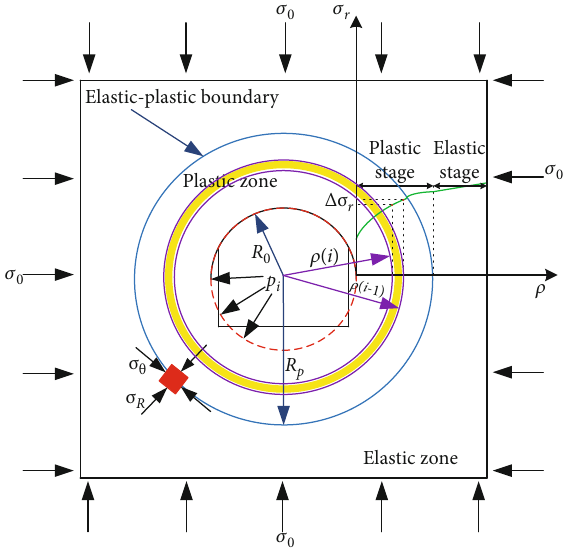
Figure 7: Radial stress distribution and plastic zone of equivalent circular roadway with fi nite number of